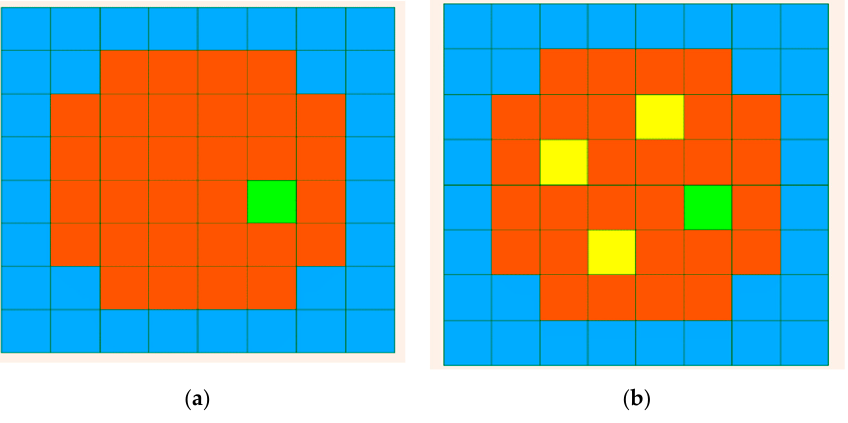
Figure 5. Transients considered: ( a ) Scenario A; ( b ) Scenario B.